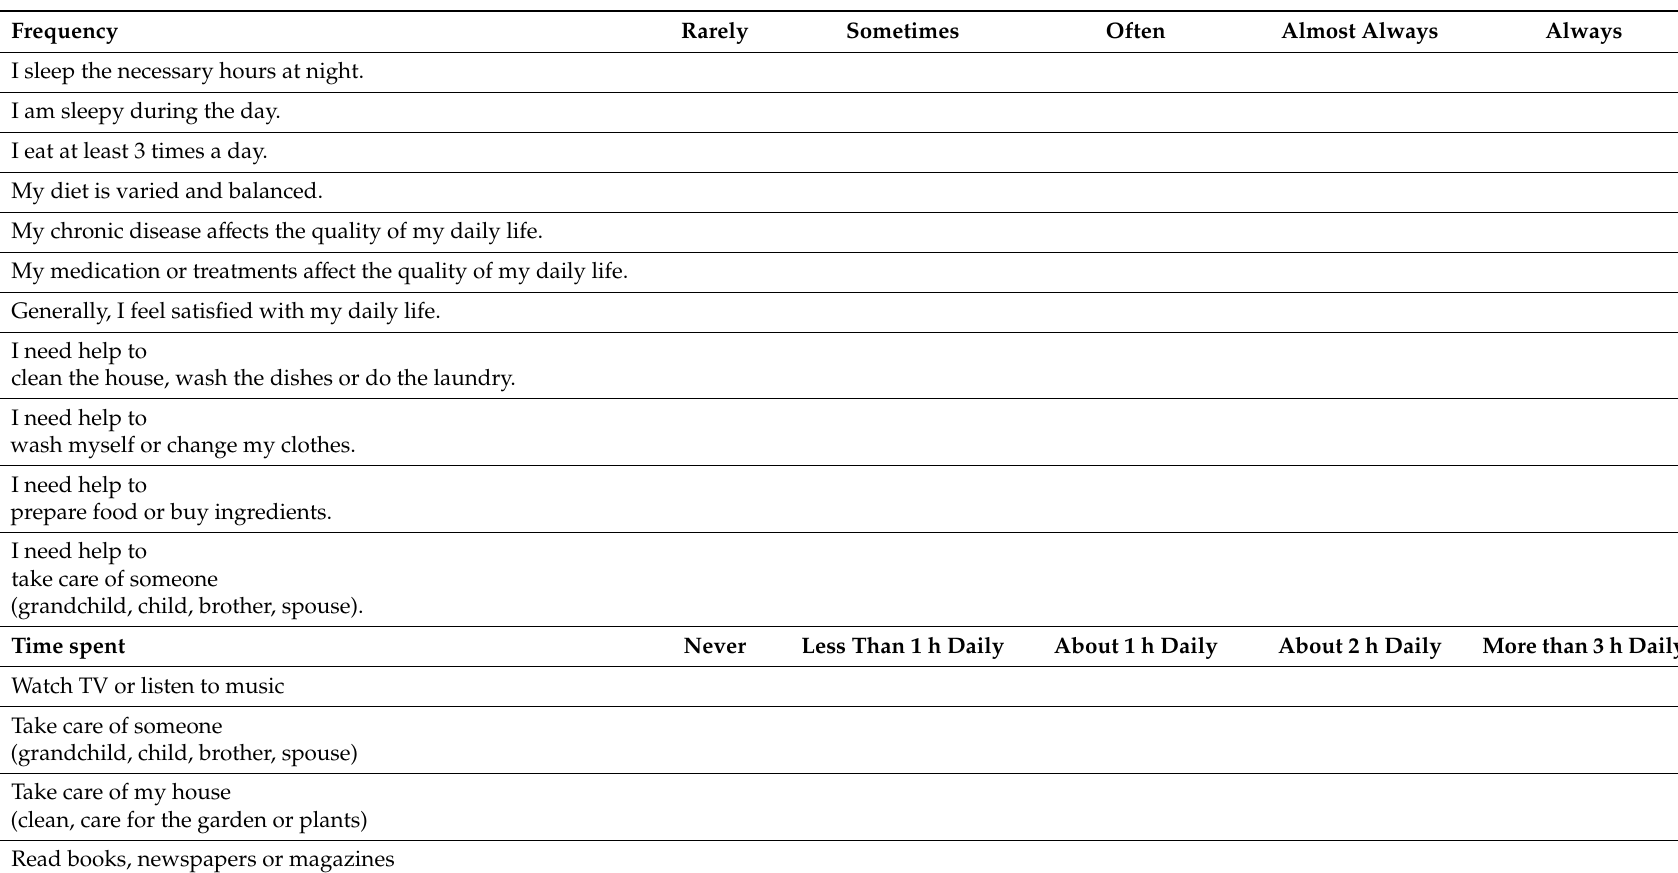
Table A3. Residentially-based lifestyle